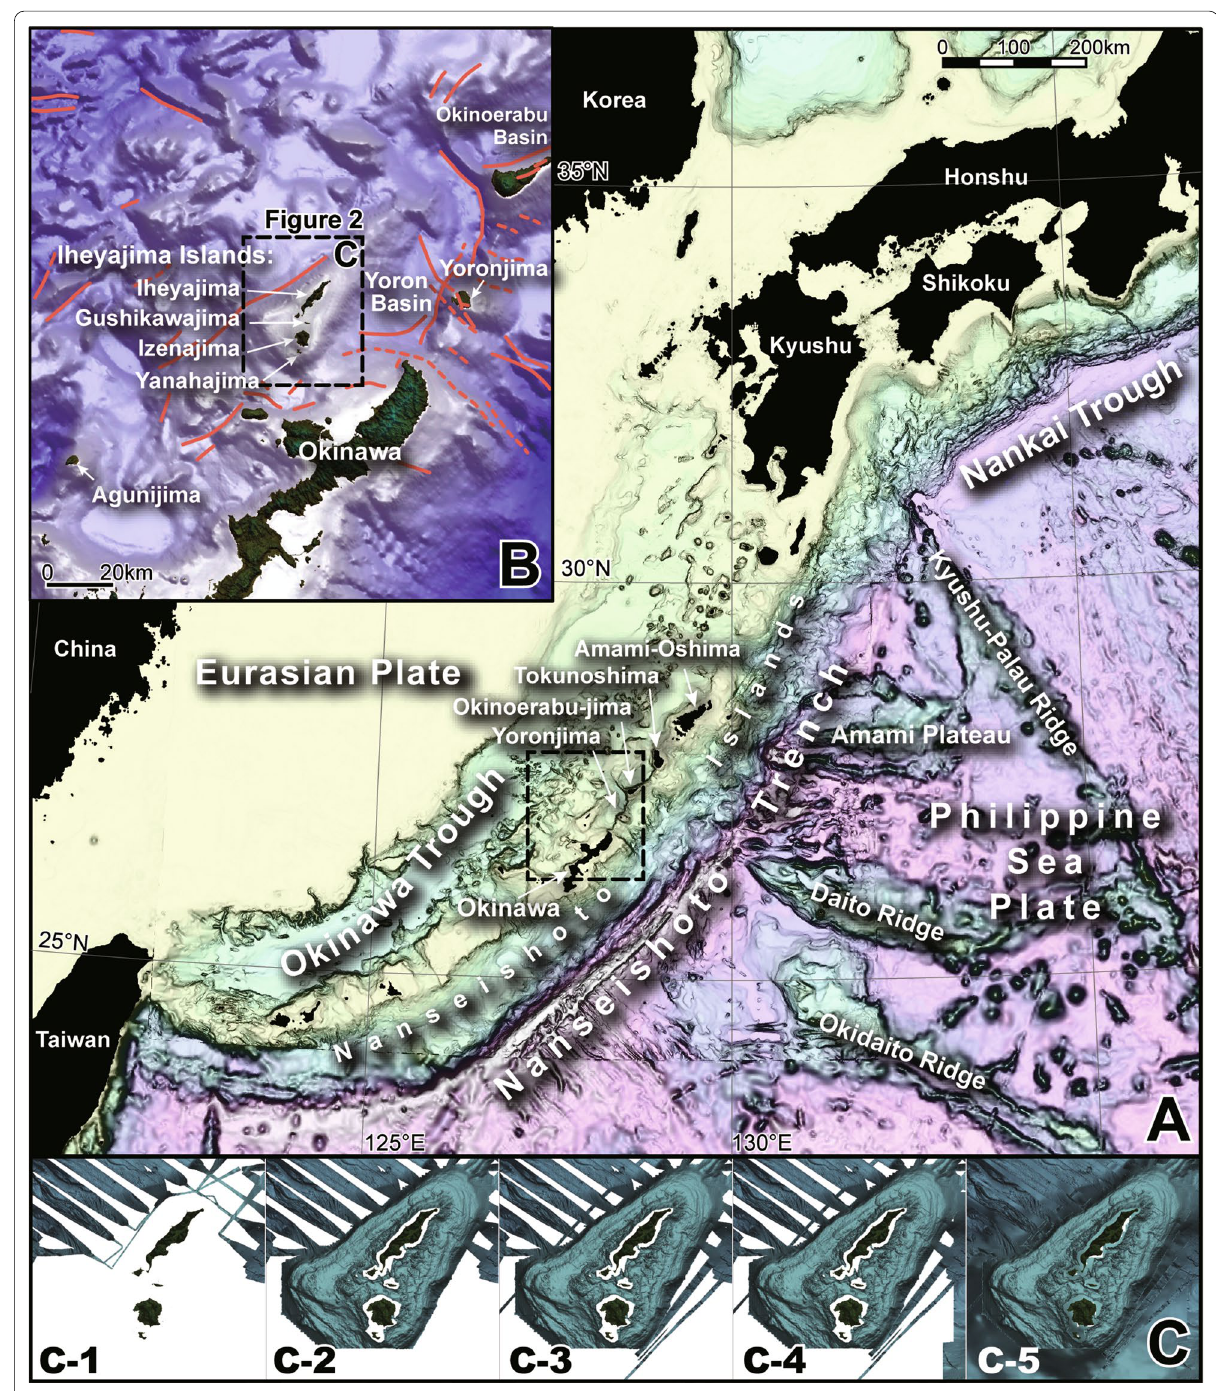
Fig. 1 Index map of the study area ( A , B ) and using data from this study ( c ). Shaded relief maps overlain by contour maps ( A and B ) use a 500 m mesh DEM (J-EGG500) from the Japanese Coast Guard (JCG), a 1-degree mesh DEM (ETOPO 1) provided by the National Center for Environmental Information (USA), and inland SRTM-3 data provided by the US Geological Survey (USGS). Red lines in B indicate active fault lines identified by the Research Group for Active Faults in Japan (1991), Arai et al. (2015), Goto et al. (2018), and Honza et al. (1977). C-1: 0.65-s-mesh DEM of Sato et al. (2013) and onshore SRTM-3 data provided by the USGS, C-2: 1.44-s-mesh DEM of Yasuhara (2013) and C-1, C-3: 2.03-s-mesh DEM data from the Darwin website of the Japan Agency for Marine-Earth Science and Technology (JAMSTEC) and C-2, C-4: 2.08-s-mesh DEM produced from the contour lines on the chart of the Japan Hydrographic Association and C-3, C-5: 9.69-s-mesh DEM of the J-EGG500 from JCG and